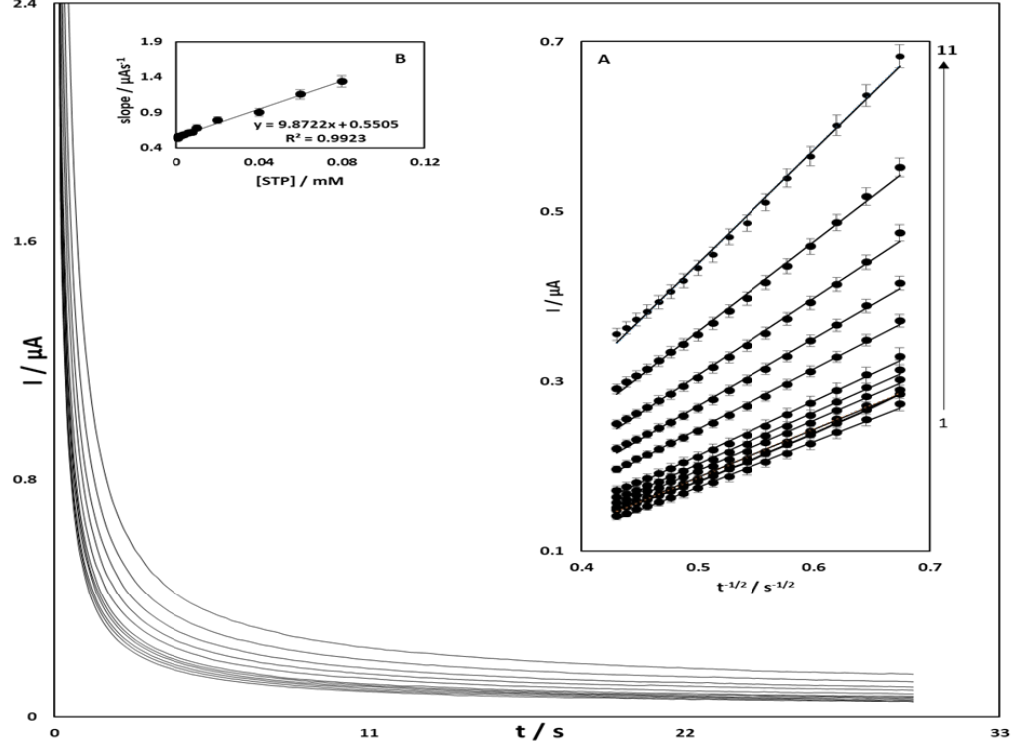
Figure 5. Chronoamperometric response of the OB/SNPs/GO/SPE in 0.1 M phosphate buffer solution pH = 7.0 at potential step of 570 mV for different concentrations of STR. The numbers 1-11 correspond to 0.001, 0.002, 0.004, 0.006, 0.008, 0.01, 0.02, 0.04, 0.06, 0.08, and 0.1 mM of STR, respectively. Insets: ( A ) plots of I versus t -1/2 obtained from the Chronoamperograms and ( B ) plot of the straight lines against the STR concentration.